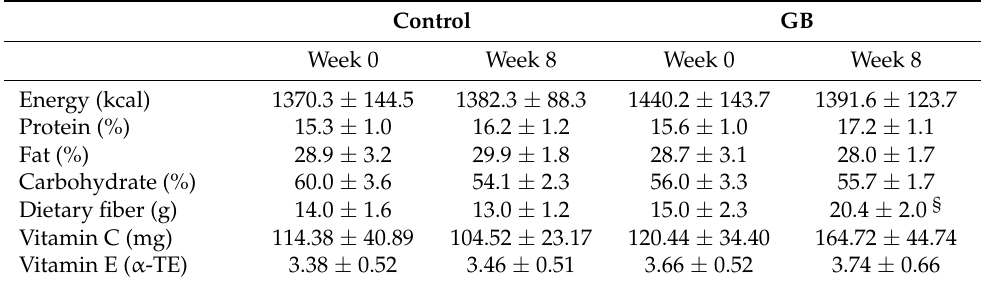
Table 2. Dietary intake during study